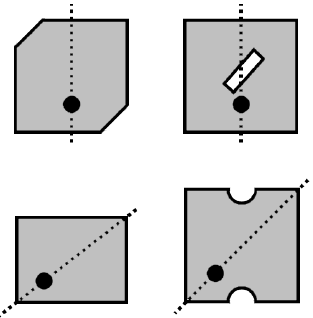
Figure 8. Single-point fed antennas examples